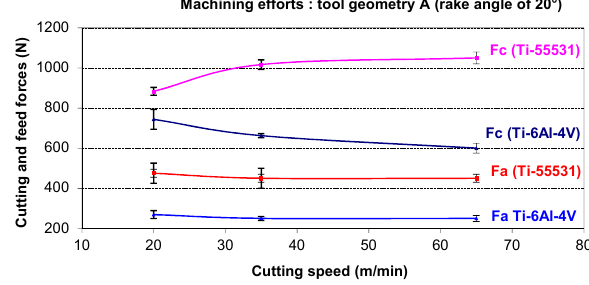
Figure 7. Cutting forces obtained for Ti-6Al-4V and Ti-55531 with tool geometry